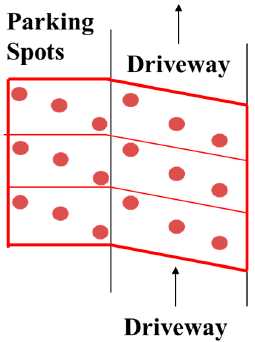
Figure 5. Infiltration testing scheme for PICP 3 and PICP 4.